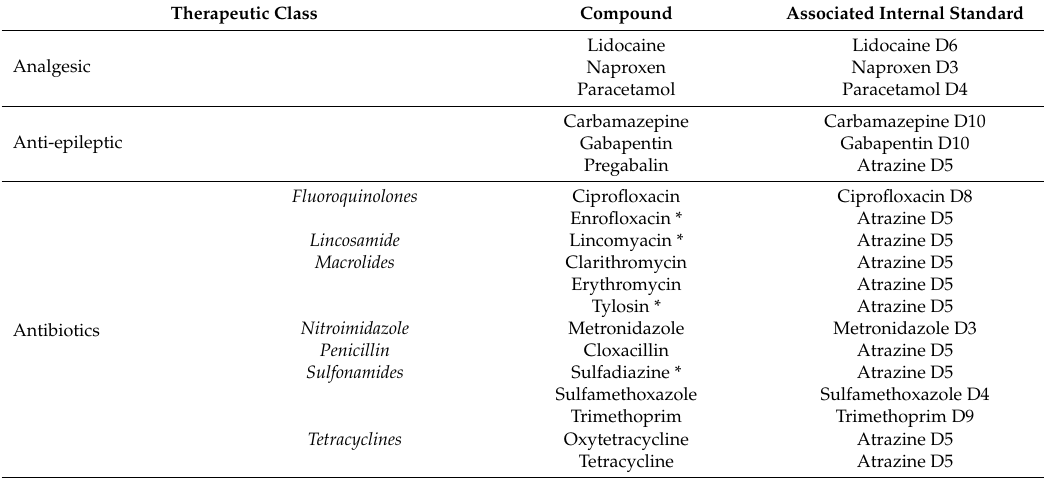
Table 1. List of monitored chemicals by therapeutic class and their associated internal